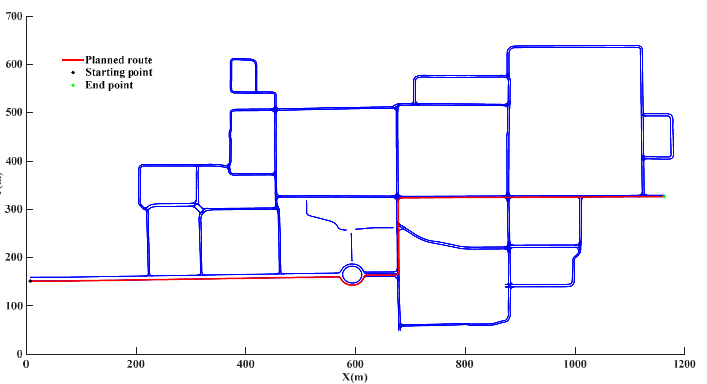
Figure 21. The blue lines represent the lane centerlines in the map demonstrated in Figure 20, and the red lines highlight the planned route.